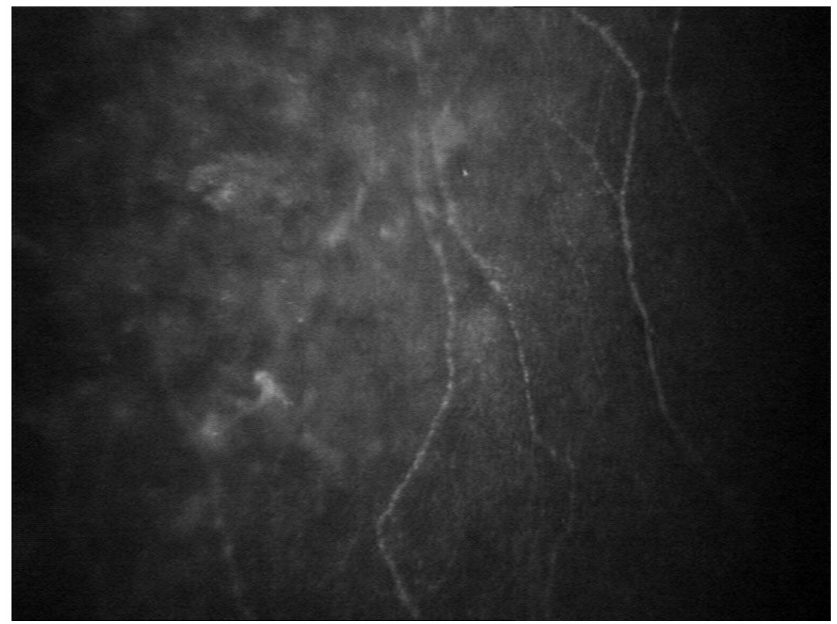
Figure 8. Poorly represented corneal nervous plexa with corneal confocal microscopy in amyloidosis. Treatment for KCS consists of lubricant eye drops in order to avoid friction on the dry cornea. In very severe cases of corneal injury due to TTR deposition, such as in the case of corneal perforation, penetrating keratoplasty (PK) may be a treatment option, even though it does not prevent a relapse because corneal amyloid deposition persists after PK